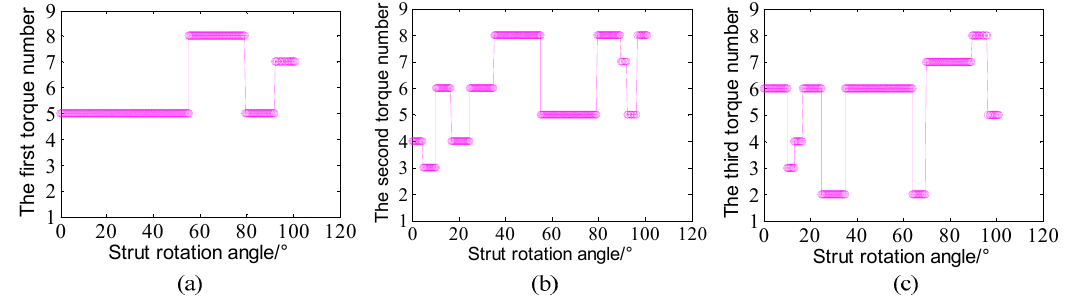
Figure 5. Influences of the top three torques on the failure probability of emergency extension under strut rotation angles: ( a ) the first torque number; ( b ) the second torque number; ( c ) the second torque number.